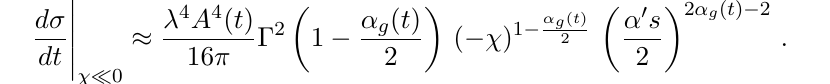
d , for each value of (cid:31)